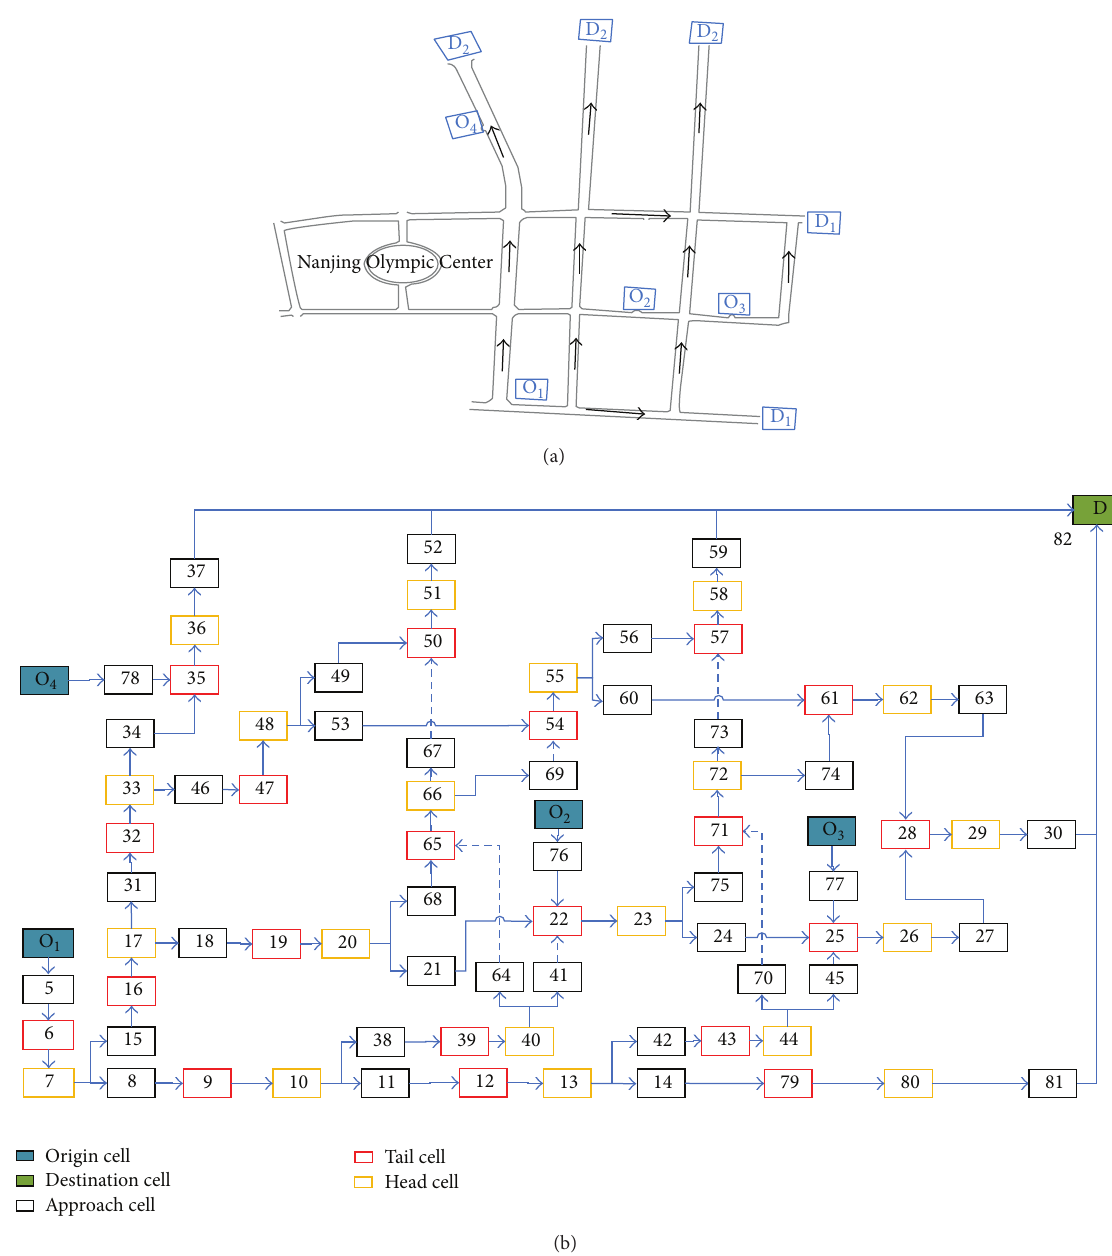
Figure 3: Evacuation road network: (a) original road network; (b) corresponding cell